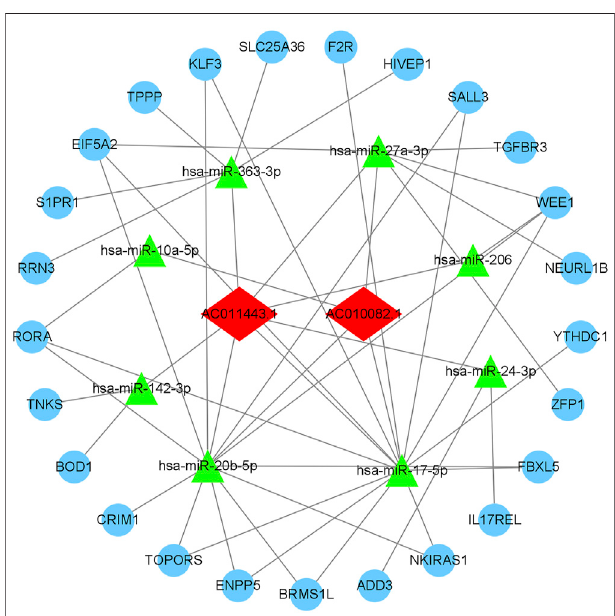
FIGURE 10 | AC010082.1- and AC011443.1-related ceRNA network. The light blue round nodes, red diamond nodes, and green triangle nodes indicate mRNA, lncRNA, and miRNA,